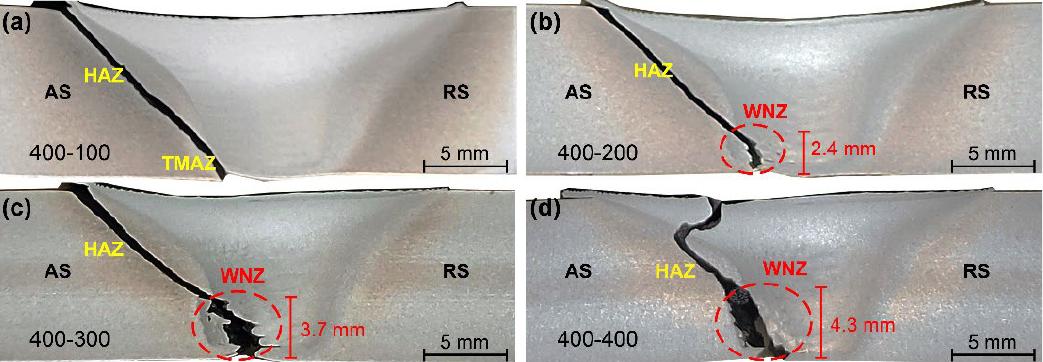
Figure 16. Fracture locations of joints by Pin-1 ( a ) 400-100, ( b ) 400-200, ( c ) 400-300, and ( d ) 400-400.